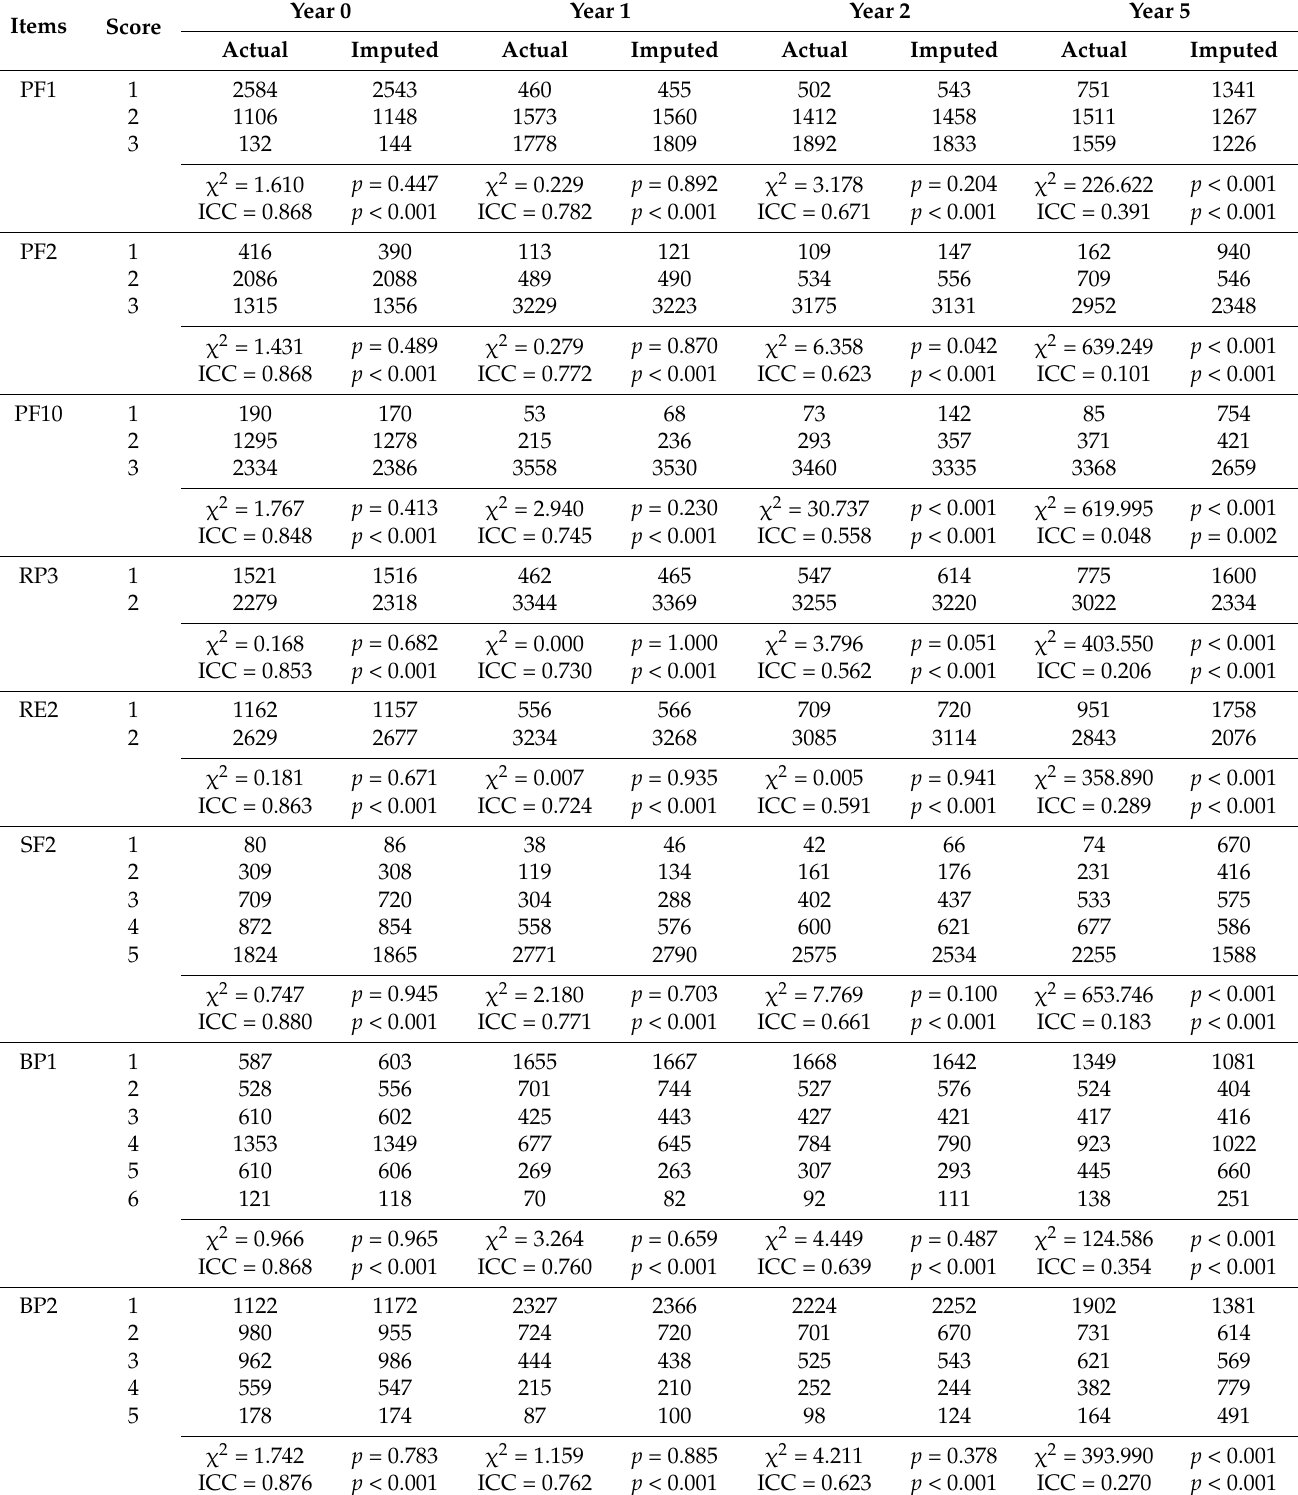
Table 3. Accuracy of multiple imputations for the selected SF-36 item